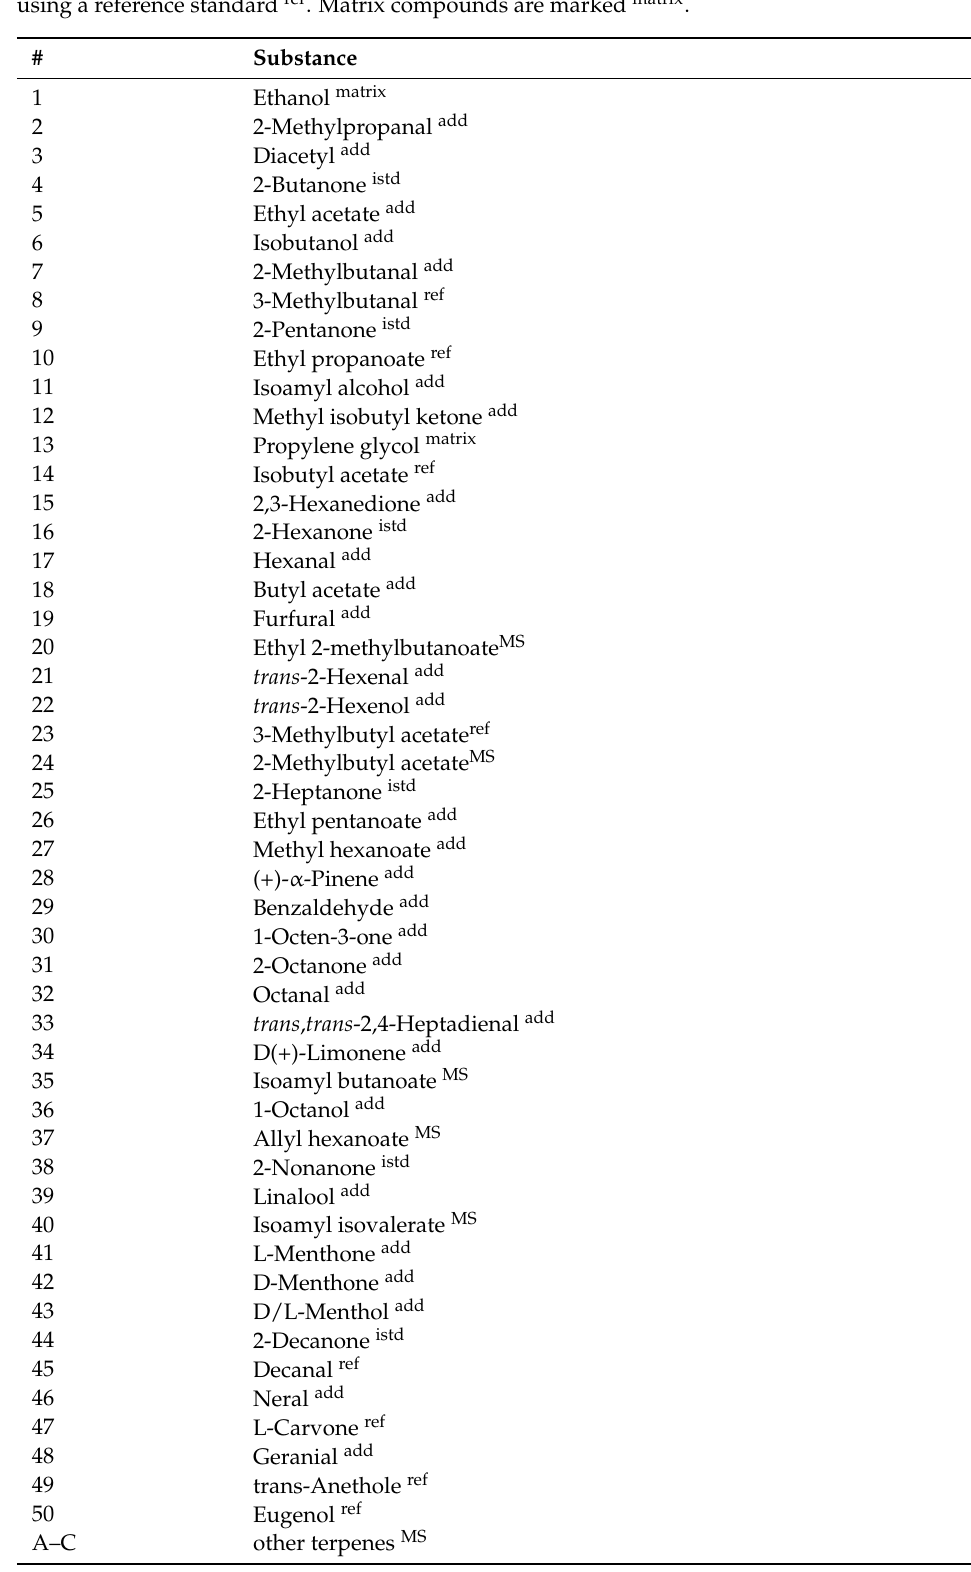
Table 2. List of substances that were identified in the partial GCxIMS plot of a banana-flavored and spiked e-liquid, shown in Figure 2. Substances that were added are marked add , substances used as internal standards istd , substances tentatively identified using the GC–MS MS and afterward verified using a reference standard ref . Matrix compounds are marked matrix